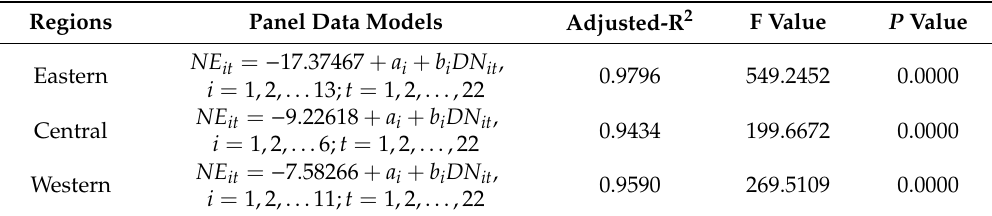
Table 2. Regression models of the three